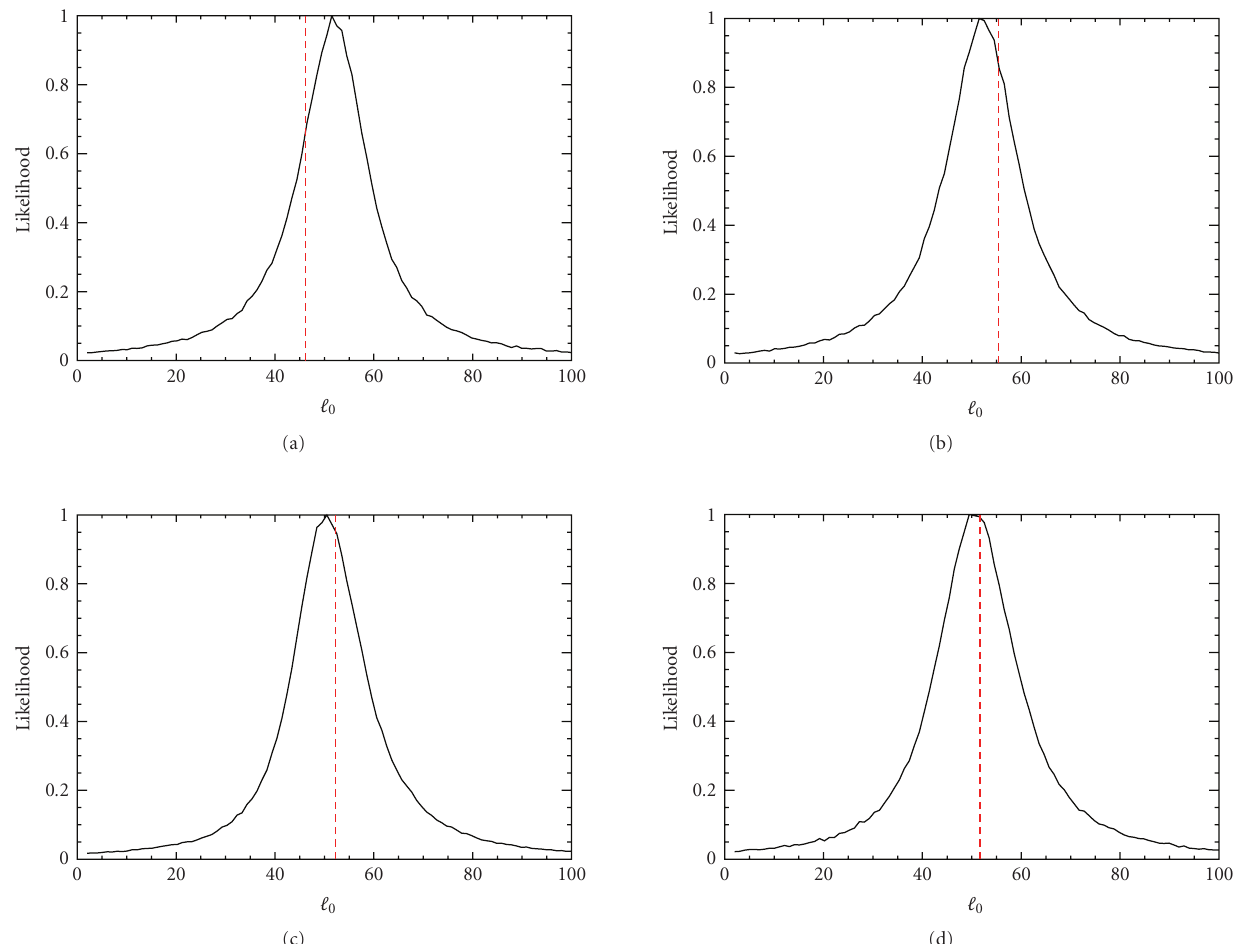
Figure 2: These plots show the results of the calculation of (cid:2) 0 for the two linear fitting routines. The top row is for the unbinned data, and the bottom row is for the binned data. The left column is the routine which minimizes the χ 2 error criterion. The right column is the least absolute deviation fitting routine.